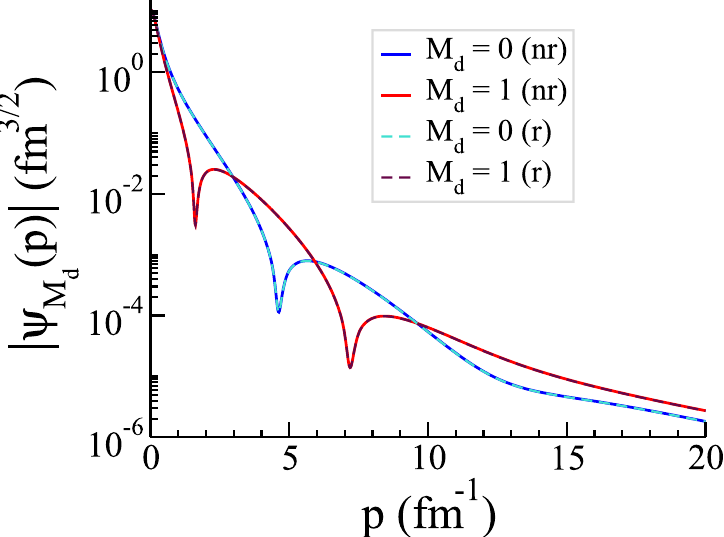
Figure 5. The absolute value of deuteron wave function components ψ 0 and ψ 1 , calculated for relativistic (r) and nonrelativistic (nr) CD-Bonn potentials, as a function of the relative momentum p